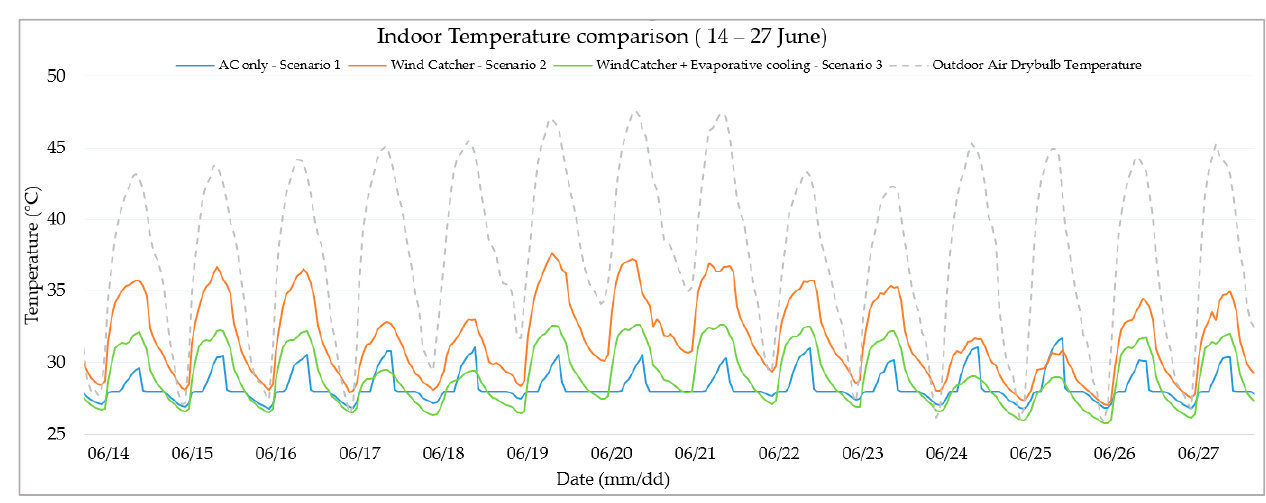
Buildings 2021 , 11 , x Figure 11. Indoor temperature comparison across the three scenarios over two weeks in June.